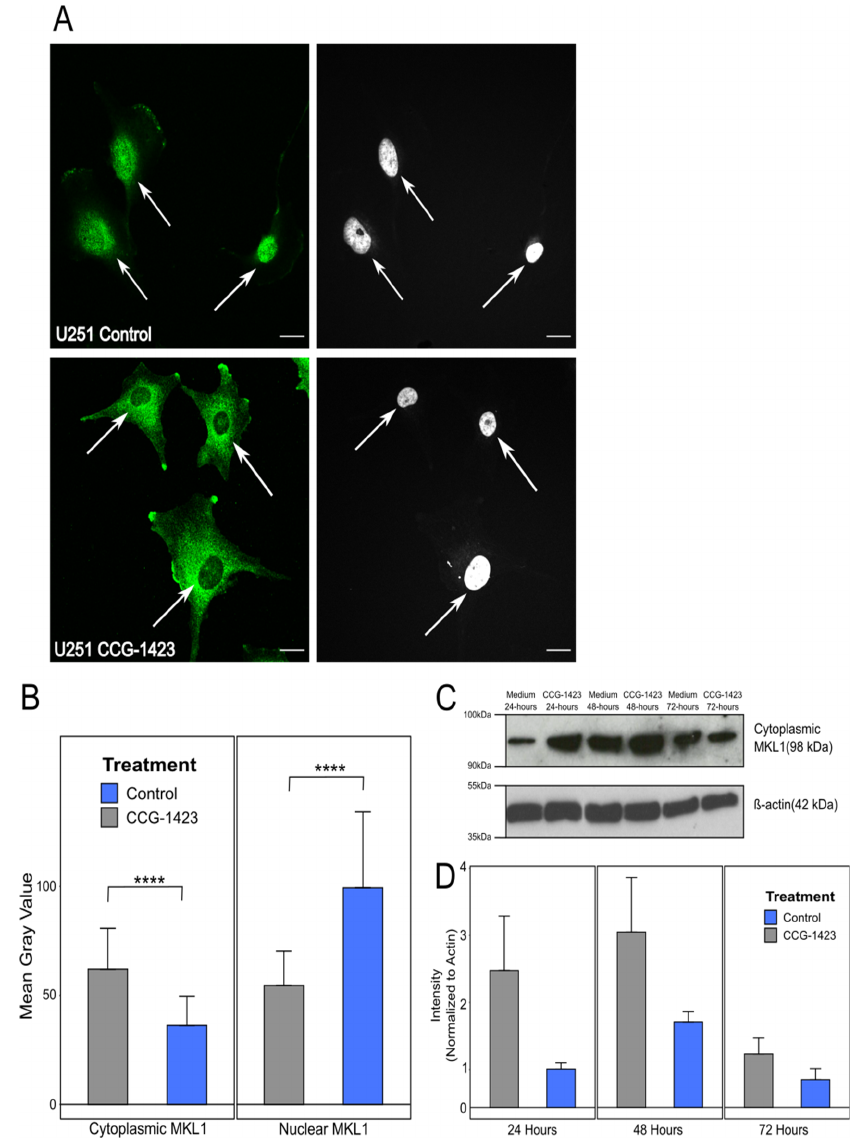
Figure 3. Immunofluorescence staining and analysis of MKL1 in untreated and CCG-1423 treated U251 cells. ( A ) Arrows show a build-up of MKL1 in the cytoplasm of treated cells compared to the control cells which show pronounced nuclear staining. Imaged on a confocal microscope at a magnification of x63. Green fluorescent stain = MKL1; right panel: nuclear DAPI stain; Scale bar = 20 µ m. ( B ) Quantification of immunofluorescence staining of MKL1 to determine differences in nuclear and cytoplasmic MKL1 localisation in untreated (control) U251 cells and U251 cells treated with CCG-1423. The images were analysed using ImageJ where a mean gray value was calculated for the nucleus and the cytoplasm of each cell. Kruskal–Wallis: p = 1.96 × 10 − 31 ( C ) The U251 cell line was treated with 500 nM of CCG-1423 and incubated for 24, 48 and 72 h before cell lysates were obtained. Protein levels of cytoplasmic MKL1 were then determined by western blot. A beta-actin control was included as a protein loading and transfer control. ( D ) Western blot analysis of the effects of CCG-1423 on U251 cells. MKL1 band intensity was quantified and normalised to the β -actin control using Image J software. Graphs show mean ± SD of 3 individual experiments. Asterisks show statistical significance where **** p ≤ 0.0001. Significant differences were marked in the graphs when available. **** p ≤